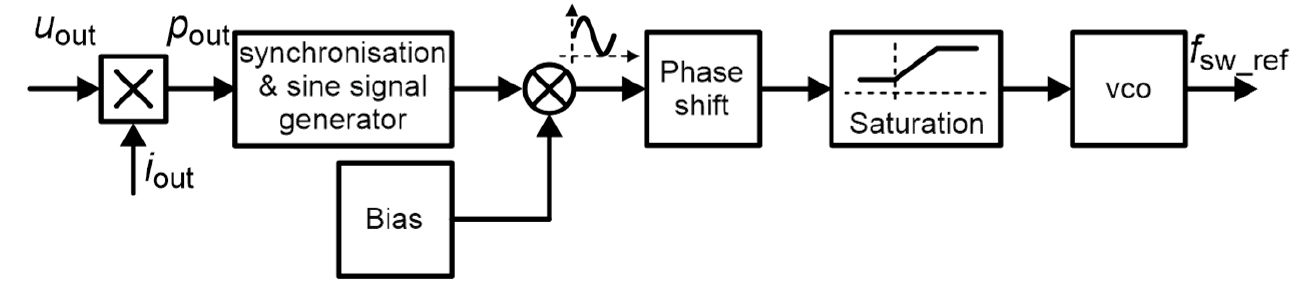
Figure 4. The concept of the closed control system for the power AIVB power control and synchro- nization with the AC output power.